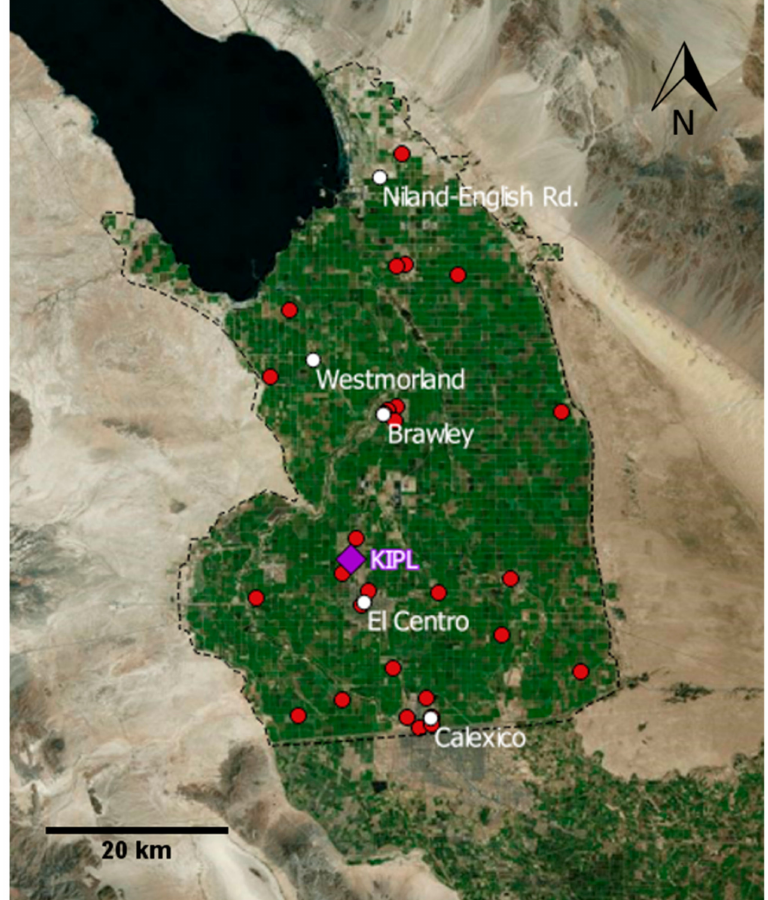
Figure 1. Map of the study area: Particulate matter (PM) mass concentration of particles less than 10 micrometers aerodynamic diameter (PM10) and PM mass concentration of particles less than 2.5 micrometers aerodynamic diameter (PM2.5) ambient air concentration measurement site locations ( white dots ), Identifying Violations A ff ecting Neighborhoods (IVAN) PM2.5 data site locations ( red dots ), and the Imperial County Municipal Airport National Weather Service meteorological site location (KIPL) ( purple diamond ). The black dashed line surrounding the Imperial Valley is used to mask the MAIAC AOD fields to retain pixels only within the